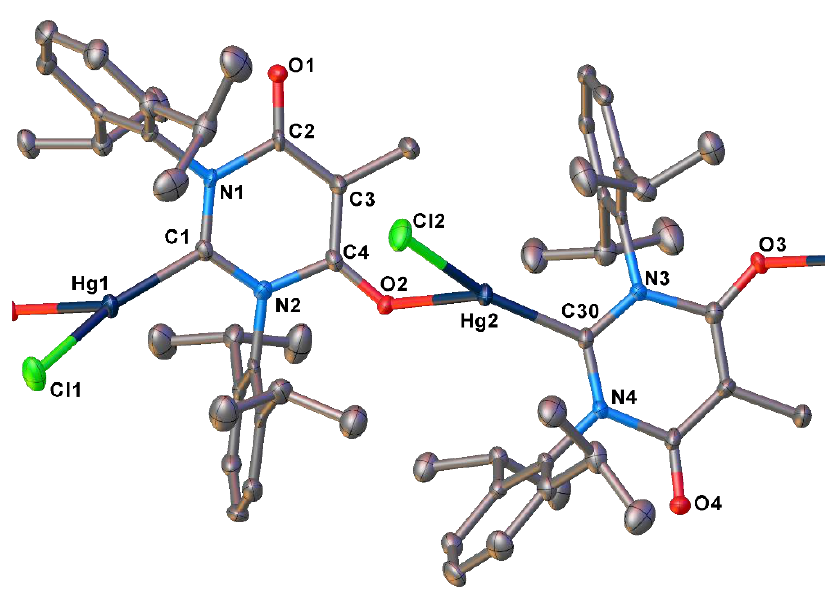
Figure 2. Molecular structure of (Me-maloNHC Dipp )HgCl ( 1b ). Hydrogen atoms have been omitted for clarity. Selected bond distances (Å) and angles ( ◦ ): Hg1-Cl1 2.3157(11), Hg1-O3 2.537(3), Hg1-C1 2.090(4), Hg2-Cl2 2.3152(11), Hg2-O2 2.529(3), Hg2-C30 2.092(4), O1-C2 1.228(5), O2-C4 1.262(5), O3-C31 1.256(5), O4-C33 1.227(5); Cl1-Hg1-O3 1 86.68(7); C1-Hg1-Cl1 157.34(12), C1-Hg1-O3 1 115.97(13), Cl2-Hg2-O2